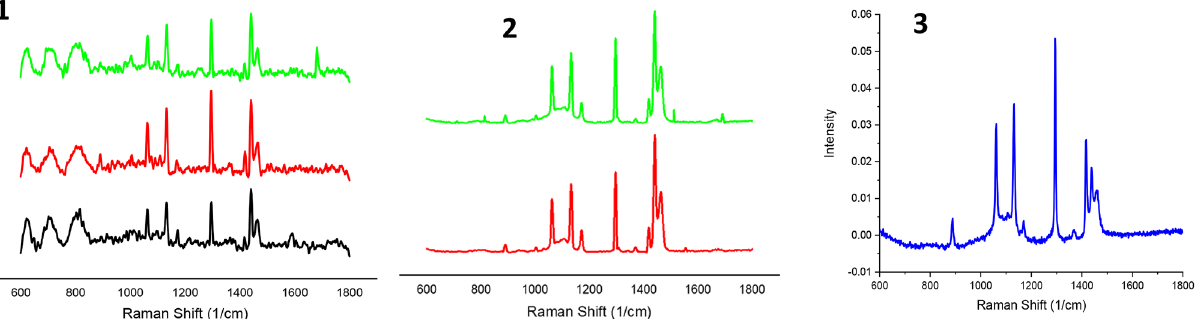
Figure 2. The pre-processed Raman spectra from all the samples obtained from the average of all the samples. Figure label number 1 is for FFPE dewaxed samples (Group 1) and figure label number 2 is for FFPE waxed samples (Group 2). Figure label number 3 is pure paraffin. (Black line: Non-lesional; Red line: EMT; Green line: